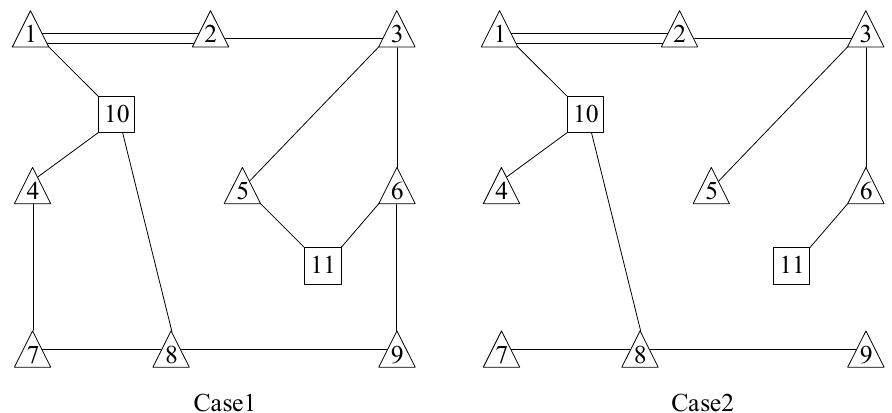
Figure 11. Gas pipelines planning topologies of different cases in stage 3.